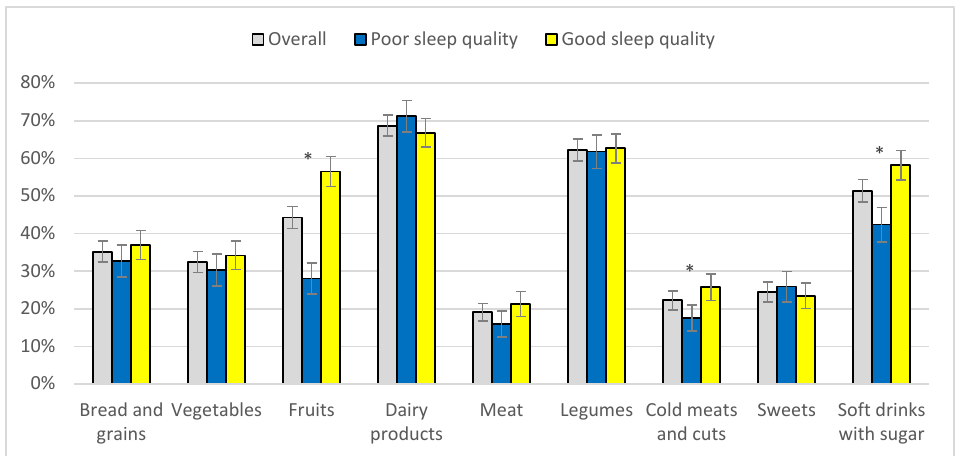
Figure 2. Level of adherence to recommended frequency for eating foods according to sleep quality. * Statistically significant differences between groups ( p < 0.05 bilateral). Note: Non ‐ adherence to recommended food intake criteria (SENC): bread and grains: less than daily; vegetables: less than daily; fruits: less than daily; dairy products: less than daily; meat: more than twice a week; legumes: less than twice a week; cold meats and cuts: once a week or more; sweets: once a week or more; and soft drinks with sugar: once a week or more. In total, 51.6% of participants reported poor sleep quality (PSQI score > 5). In the majority of the PSQI subscales, healthy diet was correlated with better sleep quality (i.e., lower PSQI scores). That said, healthy eaters were more likely to use sleep medications (Table 2). Nevertheless, it should be underscored that this difference in the use of medica ‐ tion disappeared when the analysis took the variables of age and gender into account (this information is not reflected in the table). Table 2. PSQI scores based on diet quality.